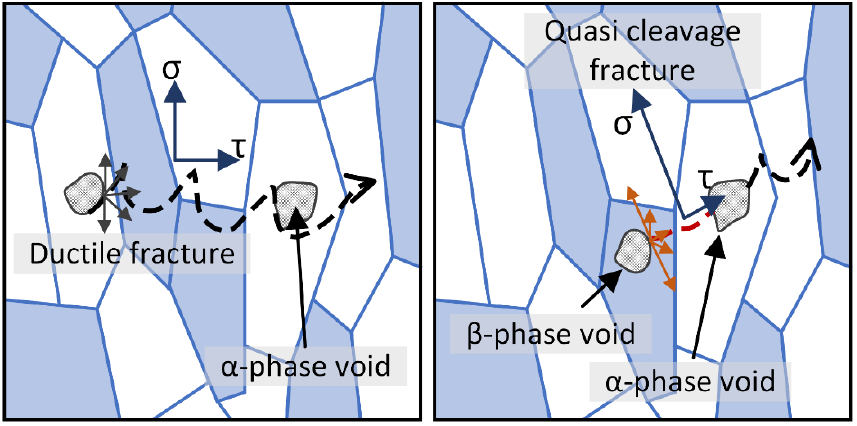
Figure 8. Temperature affects the change of fracture mechanism.